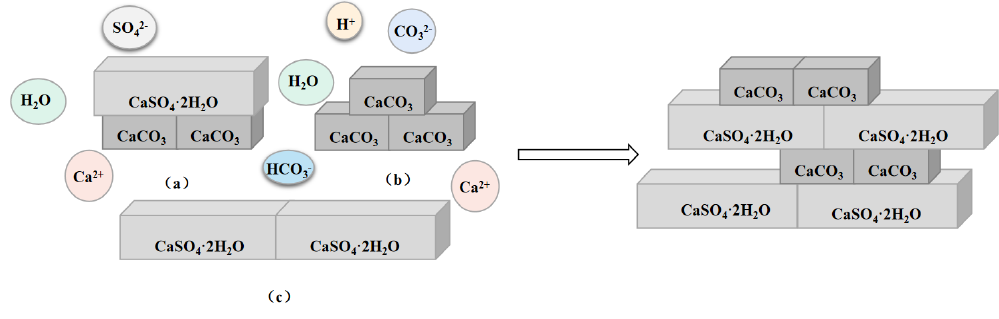
Figure 9. Deposition diagram of calcium sulfate scale as the main component in co-deposition.